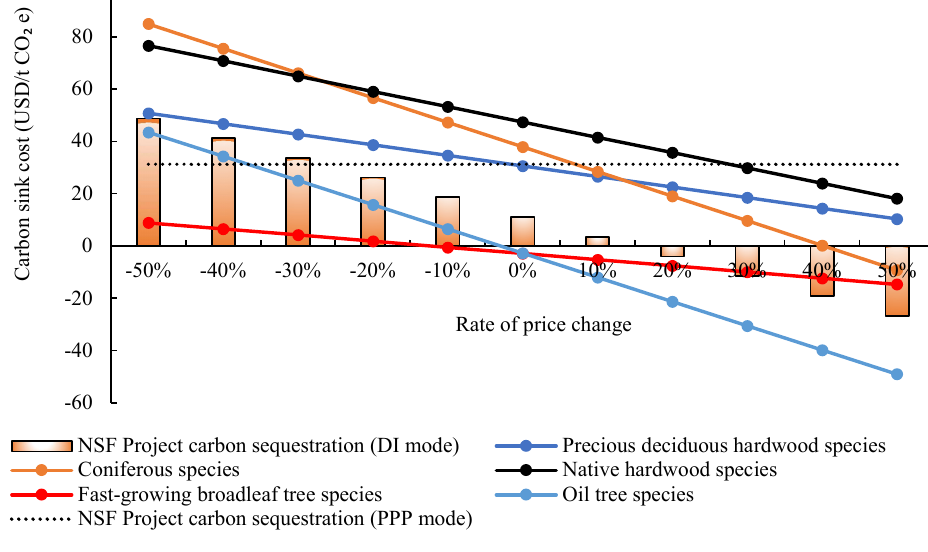
Figure 5. Carbon sink cost dynamic with wood market price change in Laohekou NAP.